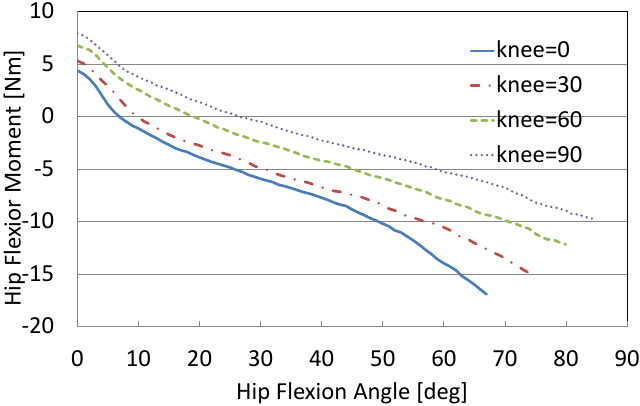
Figure 3 Mean values of passive resisting moments for younger subjects at various knee angle positions are plotted against the hip flexion angles.